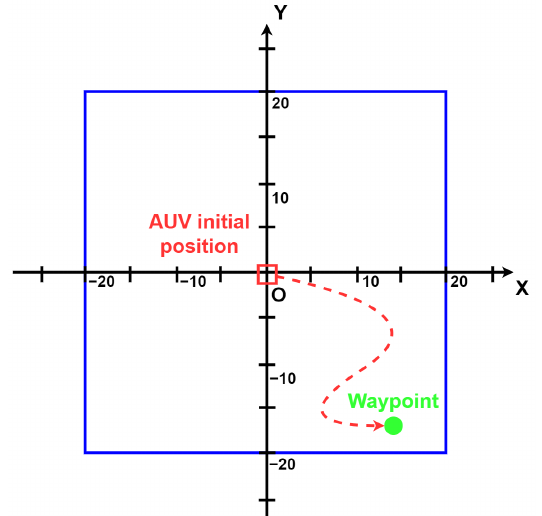
Figure 6. The bounded boxes of the control task represented in the horizontal plane